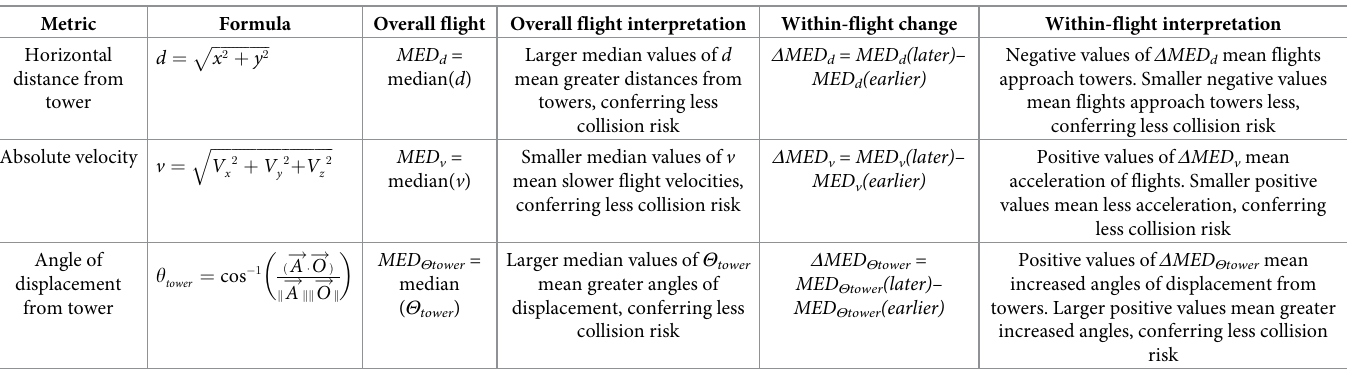
Table 1. Summary of all flight metrics and